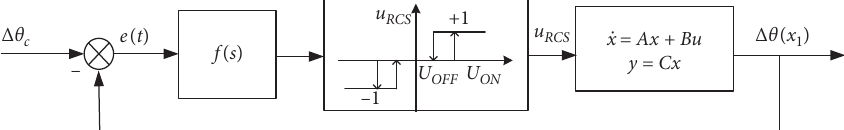
Figure 5: Structure of RCS.